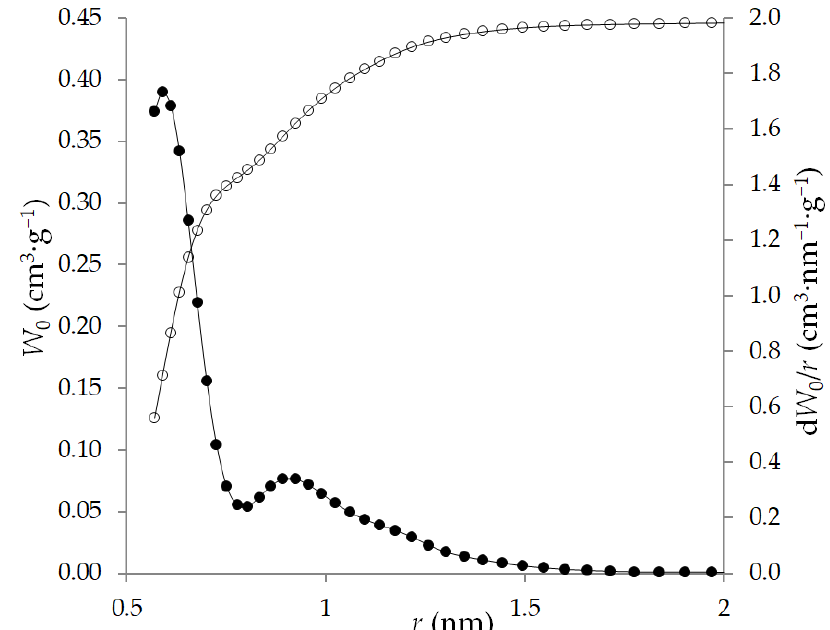
Figure 6. The QSDFT cumulative W 0 (light symbols) and differential d W 0 / r (dark symbols) pore volume distributions calculated for ACPK from the nitrogen adsorption at 77 K for a sphere pore model.